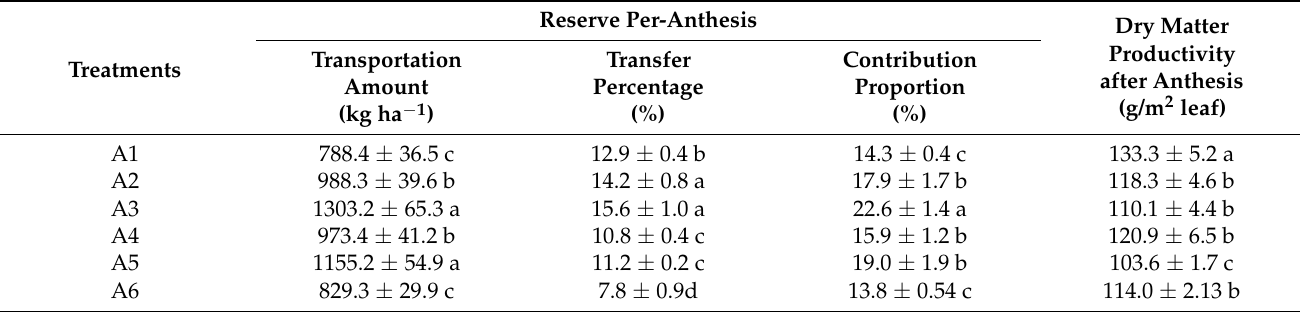
Table 4. The effects of density treatments to dry matter